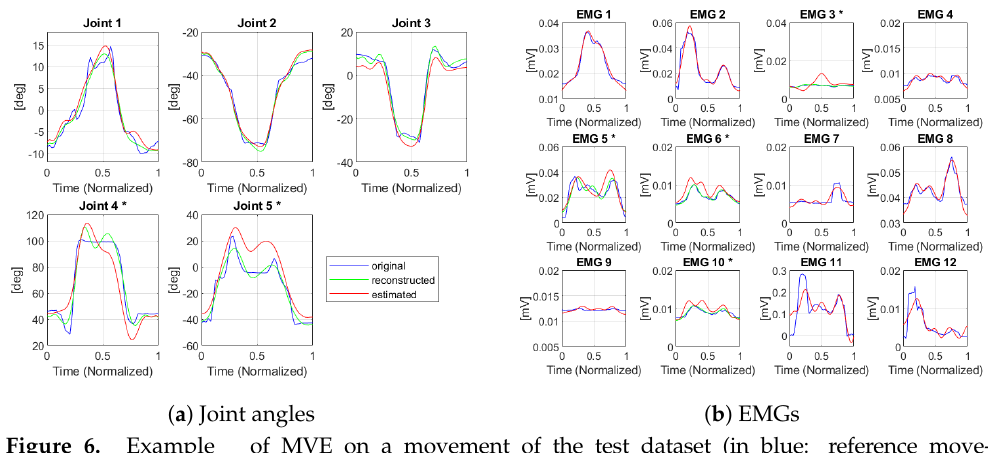
Figure 6. Example of MVE on a movement of the test dataset (in blue: reference move- ment; in green: movement reconstruction with fPCs; in red: movement obtained through MVE); * = non − measured